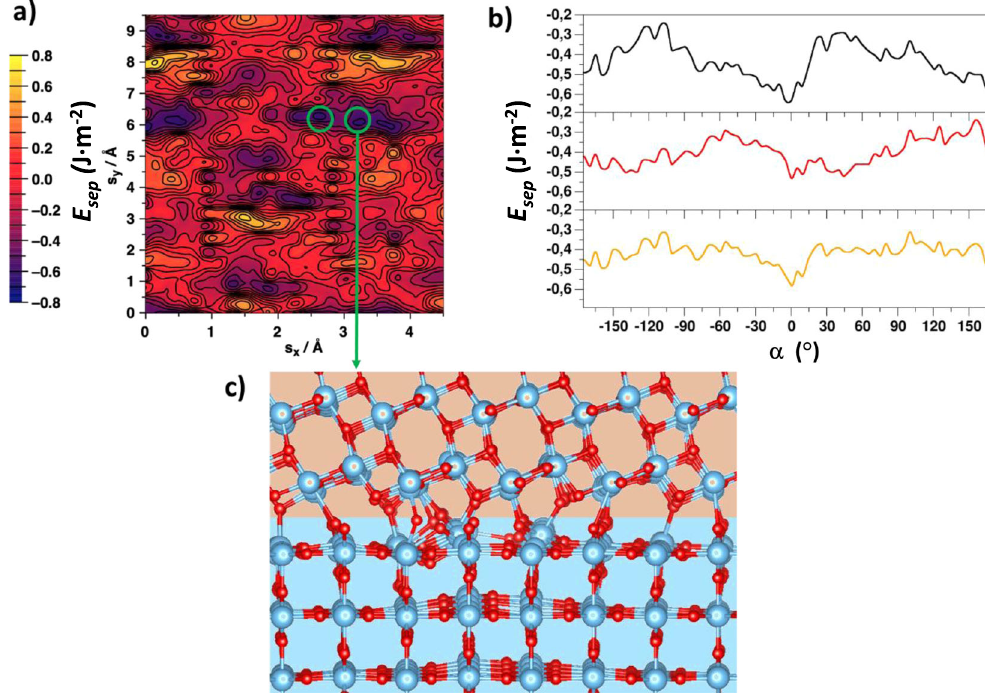
Fig.6|Applicationofthediskinterfacemethodtotheanatase(101)/rutile(110) interface. a Relative energetic stability displacement scan of the anatase (101)/ rutile (110) interface at α = 0°. b Upper two plots (black and red) show twist angle scans for two low-energy displacements circled in a . The lower orange line shows